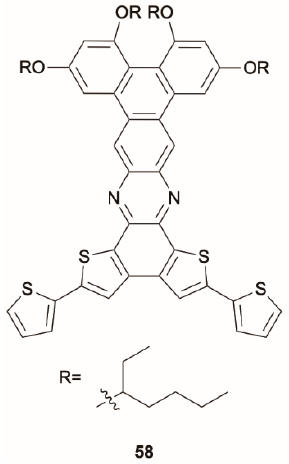
Figure 13. OLED EL spectra of 58 compared to solution PL (gray line) and delayed PL from dilute dispersions in polystyrene films (dashed line). The delayed PL is measured in vacuo to prevent triplet quenching. Adapted with permission from [61].